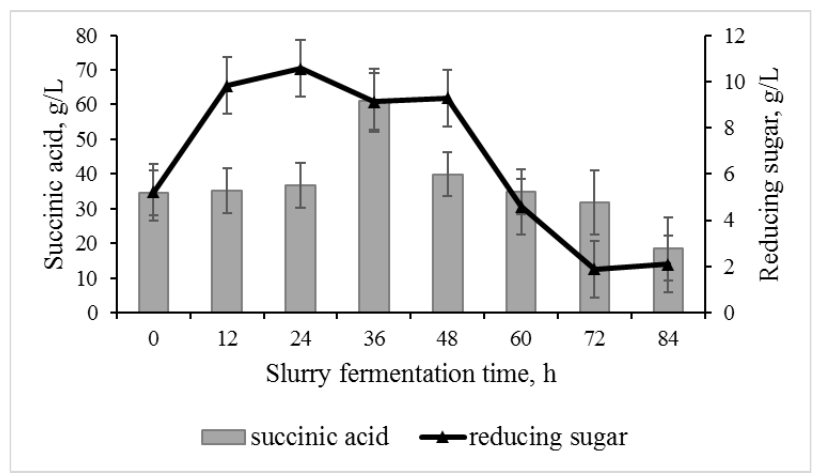
Figure 4. Time profile of succinic acid concentration and residual sugar from a mixed culture of Trichoderma reesei , Aspergillus niger , and Phanerochaete chrysosporium on 4:1 birch wood chip–soybean hull biomass during 84 h of slurry fermentation following the addition of fresh C-rich substrate.